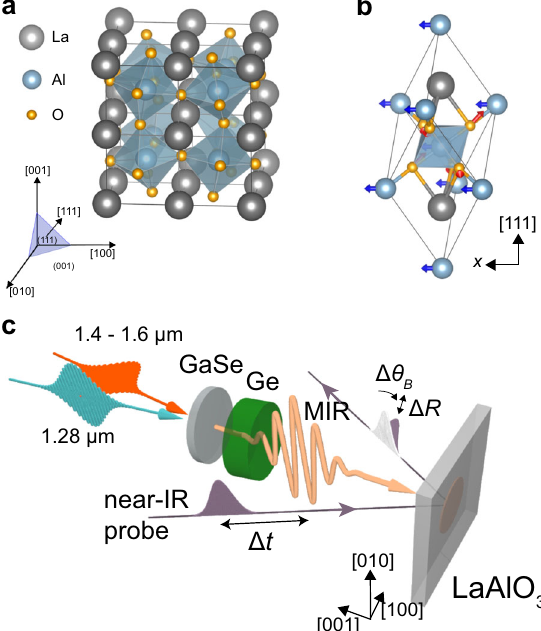
Fig. 1 Crystal structure and experimental geometry. a The crystal structure of LaAlO 3 , with indications of the different crystallographic directions. The rhombohedral distortion from the high-temperature cubic phase is due to out-of-phase rotations of the oxygen octahedra about the [111] pc axis. b Atomic motion corresponding to the infrared-active E u stretching mode, polarized in the (111) plane in the x -direction. c Schematic illustration of the experimental scheme. The mid-IR pulse is generated by difference frequency mixing from two near-infrared pulses in a GaSe crystal, after which the mid-IR pulses are fi ltered by a germanium (Ge) fi lter. Following the mid-IR excitation, the ensuing changes in optical properties are probed with a time-delayed near-infrared pulse. The pump-induced changes to the re fl ection intensity Δ R and rotation Δ θ B of the polarization plane are monitored.